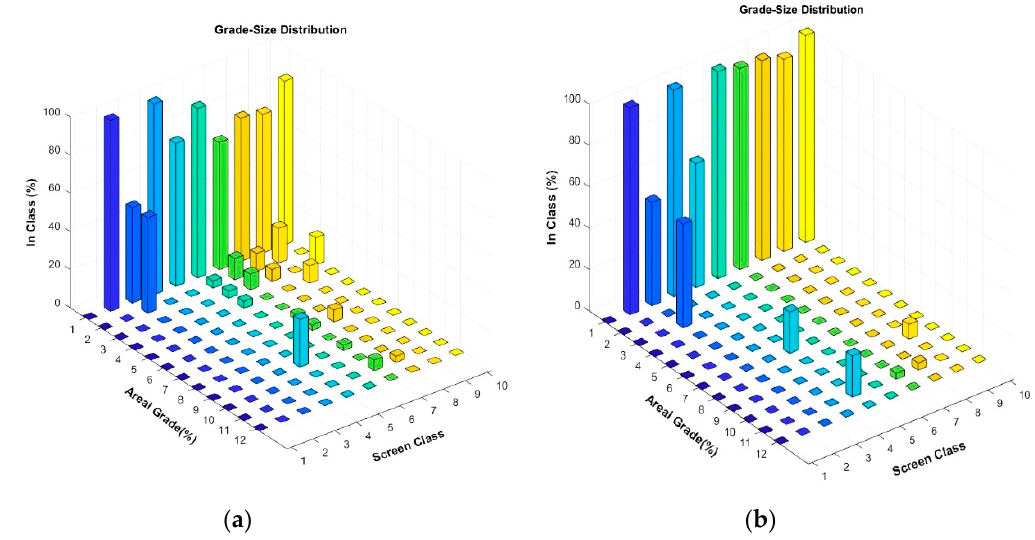
Figure 4. ( a ) Liberation spectrum of random breakage of ore of Figure 2; ( b ) liberation spectrum of preferential breakage of ore of Figure 2.